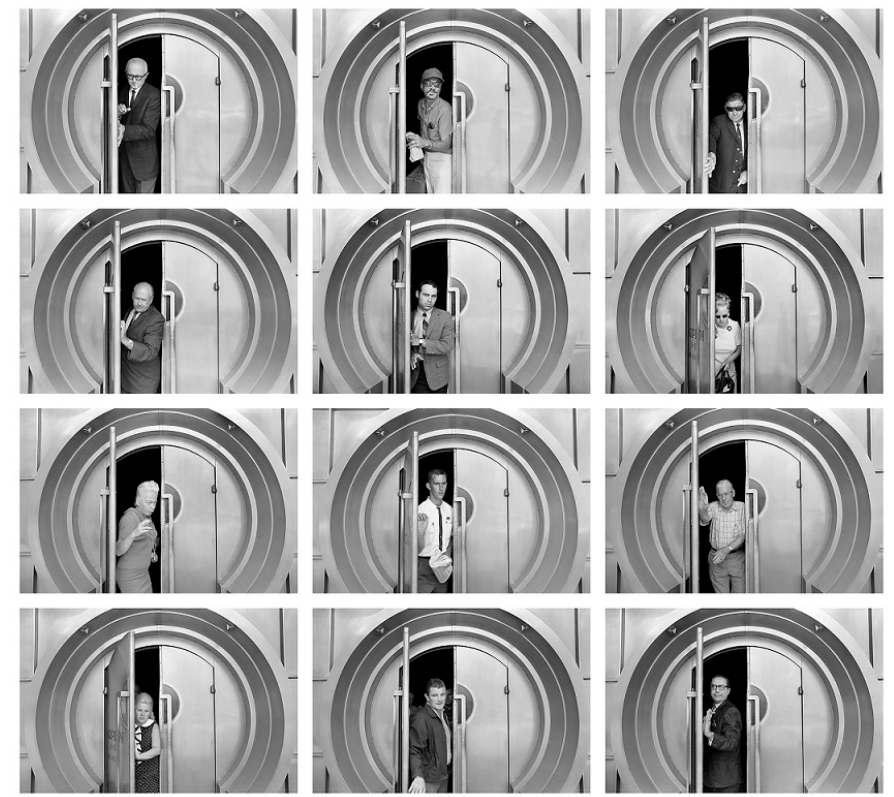
Figure 10. Anthony Hernandez, Los Angeles (1971,) © Anthony Hernandez.